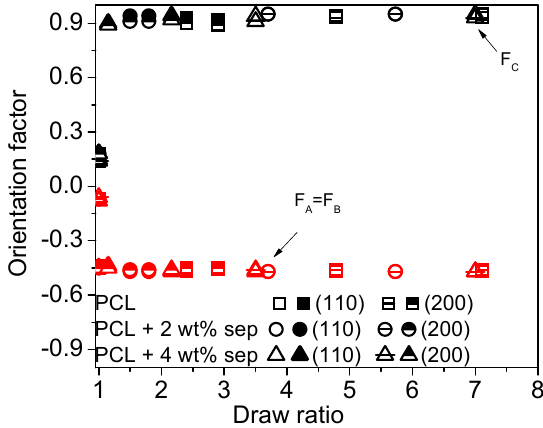
Figure 11. The Hermans’ orientation factor calculated from the 2D WAXD images. The open symbols correspond to films processed using open chill rolls, while the closed symbols correspond to closed chill rolls. Both the orientation calculated from the (110) and the (200) directions are plotted. The black symbols show the orientation factor of the c -axis of the crystals. The red symbols show the orientation factor calculated for the a -axis and b -axis of the polymer crystals.